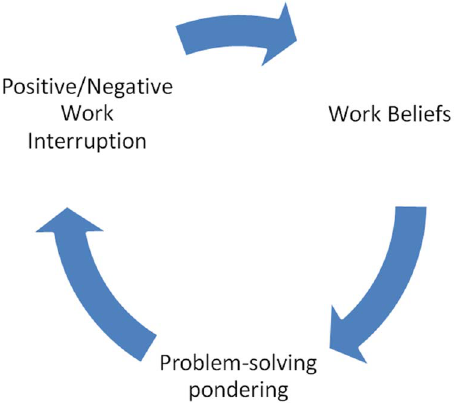
Figure 1. The role of work beliefs and work interruptions in problem-solving